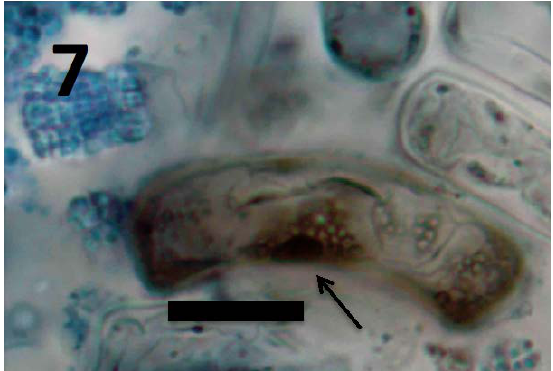
Figure 7. Root cells of Daucus carota seedling showing cluster of L-forms of M. luteus (arrow; bar = 20 µm; stained with 3,3-diaminobenzidine followed by aniline blue).